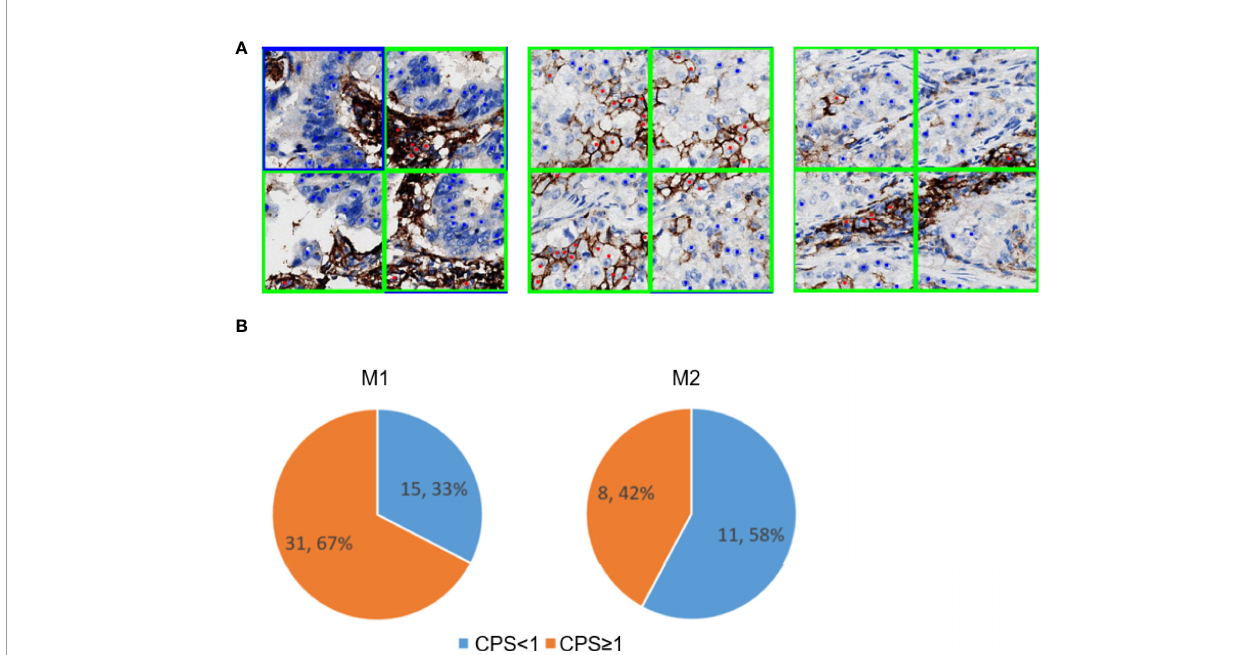
FIGURE 6 | PD-L1-positive immune cells patch fi lter module. (A) Predicted tumor and immune patch annotated with blue and green squares, respectively. The predicted PD-L1-negative tumor cells and PD-L1-positive tumor cells are indicated with blue and red dots, respectively. (B) Performance of the immune fi lter module in M1 (left) and M2 (right). These pie charts show the percentage offalse positive slides with CPS <1 and ≥